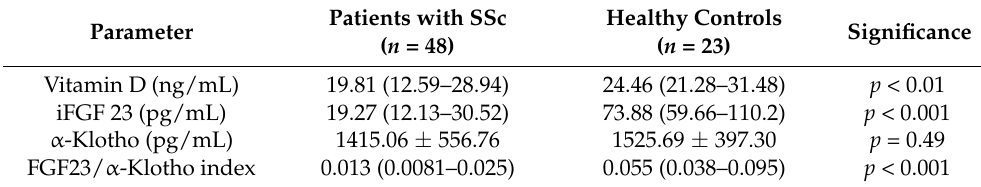
Table 2. Vitamin D, FGF 23, α -Klotho and FGF23/Klotho index in patients with SSc and healthy subjects.